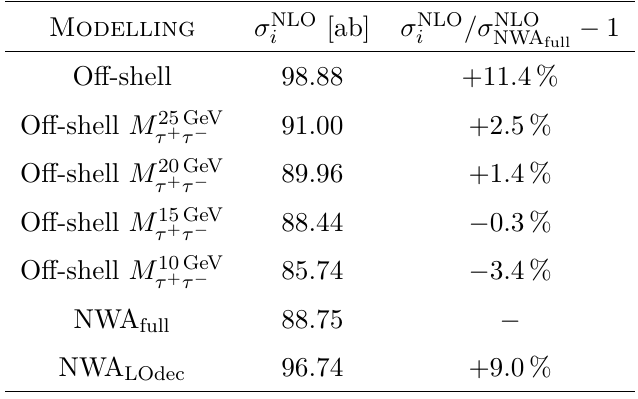
Table 7 . NLO integrated fiducial cross sections for the for pp → e + ν e µ − ¯ ν µ b ¯ b τ + τ − + X at √ the LHC with s = 13 TeV. The full off-shell prediction and various NWA results are presented. Also given are the full off-shell findings with the additional | M − m Z | < X cut, where X ∈ τ + τ − { 25 , 20 , 15 , 10 } GeV. The latter is denoted as M X . The NNPDF3.1 PDF sets are dynamical scale τ + τ − setting, µ R = µ F = µ 0 = H T / 3 , are